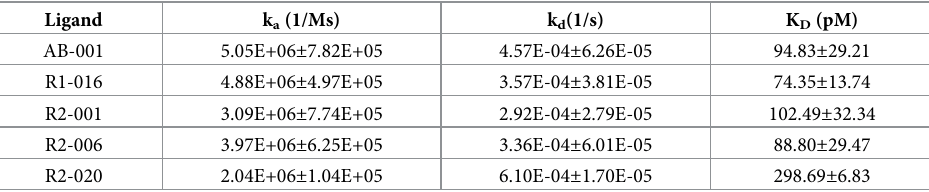
Table 1. Biacore binding analysis of top viscosity reducing